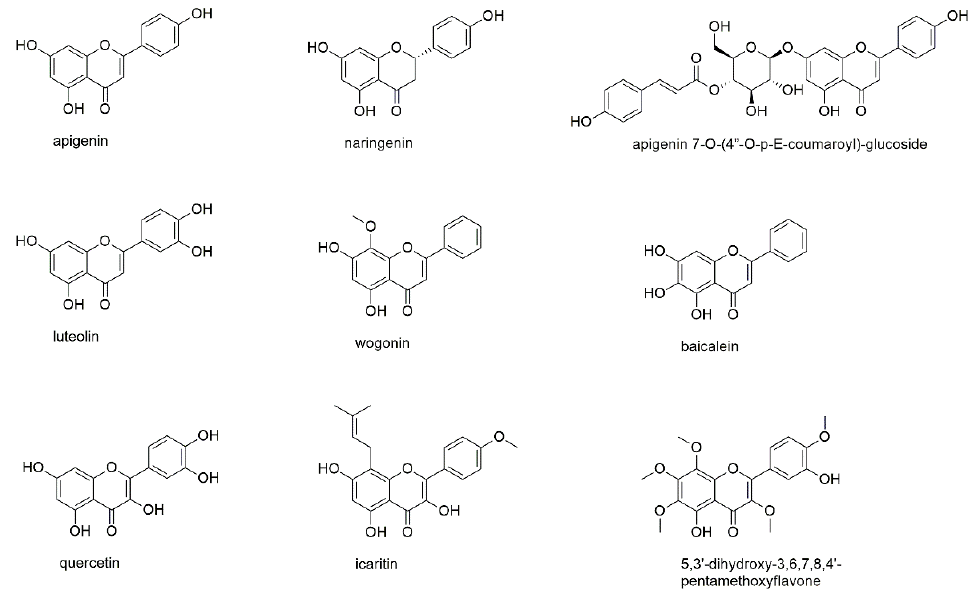
Figure 8. Flavonoids with reported activity against myeloma cell lines.